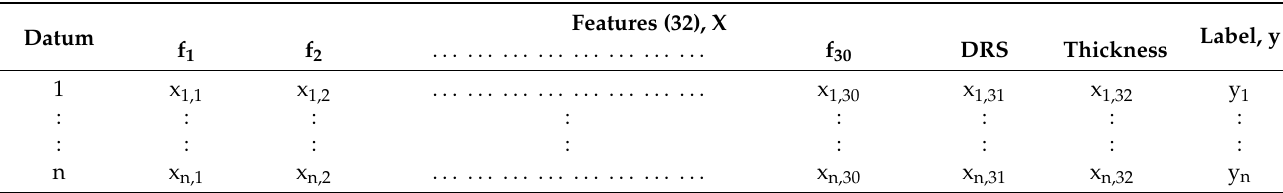
Table 2. Structure of the